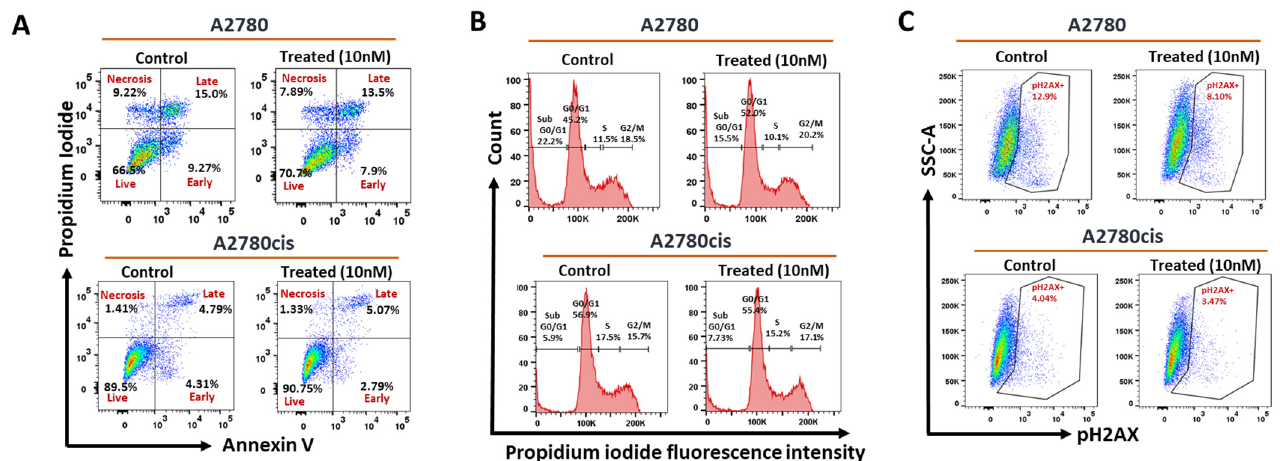
Figure 3. Effect of AhR activation on apoptosis, cell cycle, and phoshoH2AX levels in A2780 and A2780cis cell lines. A2780 and A2780cis cells were treated with wide concentrations of TCDD at different time intervals. ( A ) apoptosis, ( B ) cell cycle phases, and ( C ) phoshoH2AX levels in both A2780 and A2780cis cells were determined by flow cytometric